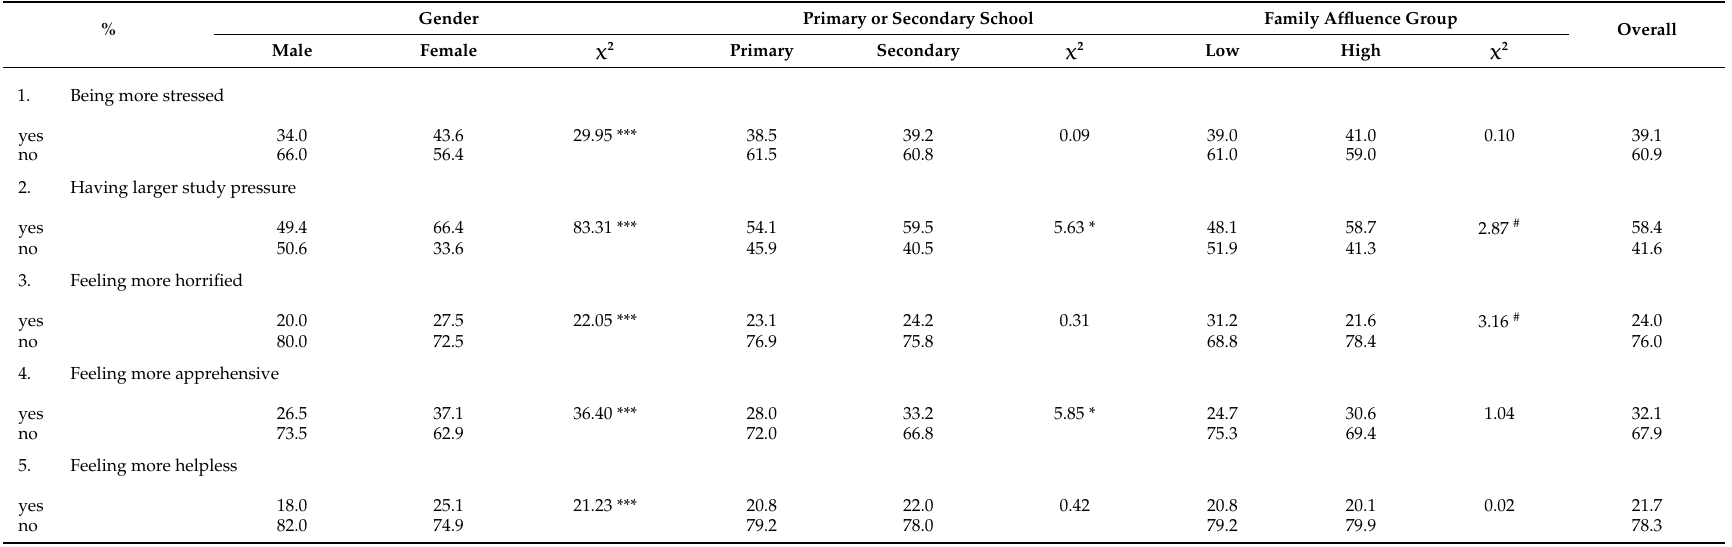
Table 4. The negative impacts on mental health by groups with Chi Square ( χ 2 ) Test ( N = 2863).